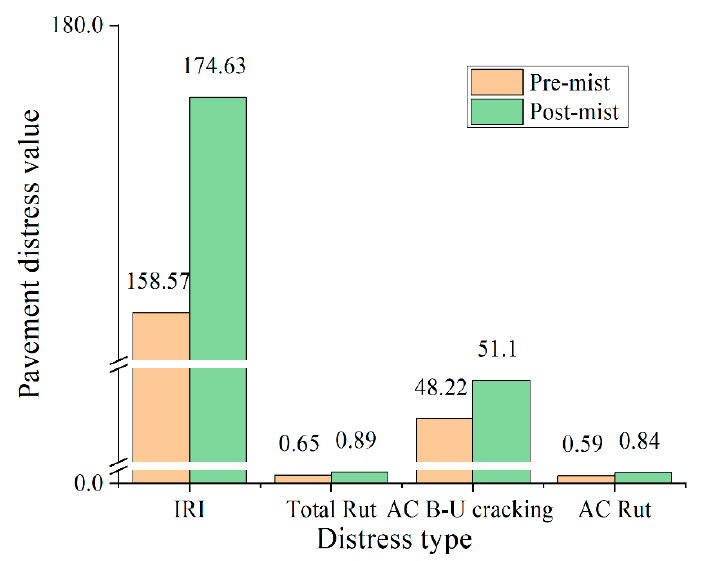
Figure 15. Pavement distress prediction by the dynamic modulus of CIR (pre-mist and post- mist). Note: IRI smoothness (in/mile or 0.016 m/km), Total Rut (in or 0.0254 m), AC B-U(bottom-up) cracking (% lane area), AC Rut (in or 0.0254 m), only consider the difference of 12.7 cm CIR layers. Table 3. DSR results of RAP and CIR used in this study.